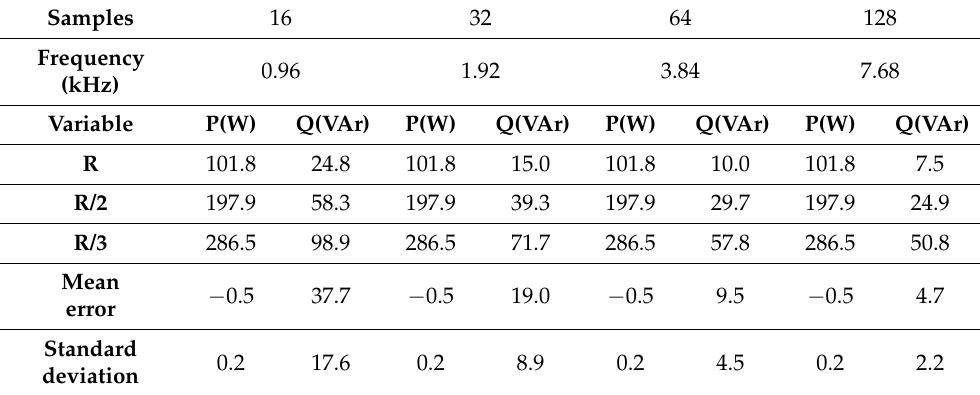
Table 9. Powers evaluated by CPT for RL loads considering 16, 32, 64, and 128 samples.